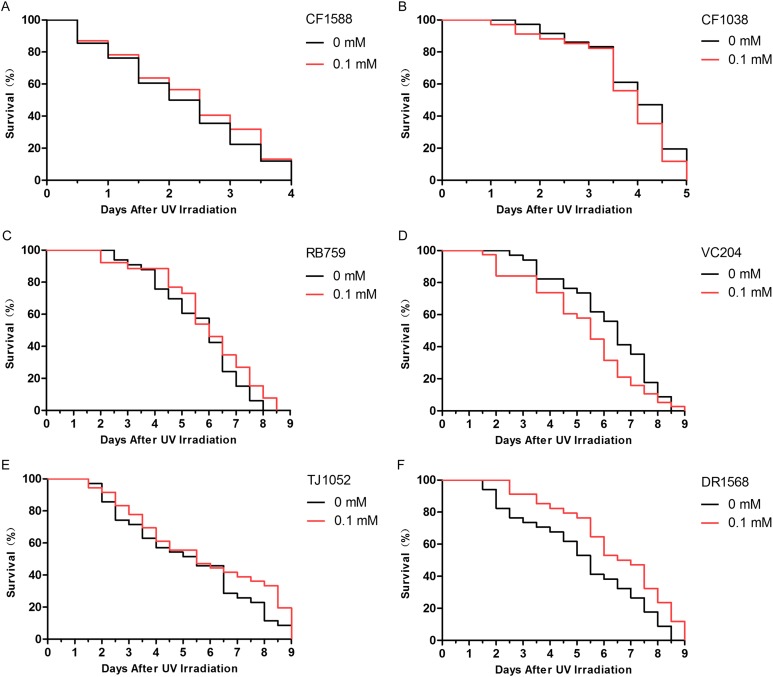
Didymin acted through the insulin/IGF-1-like signaling pathway in C. elegans.Six kinds of adult mutant nematodes were treated with 0.1 mM didymin for 48 h, followed by UV irradiation. The didymin-treated mutants (A) daf-2 and daf-16 (n > 100, p > 0.05), (B) daf-16 (mu86) (n > 100, p > 0.05), (C) akt-1 (ok525) (n > 100, p > 0.05), (D) akt-2 (ok393) (n > 100, p > 0.05), and (E) age-1 (hx546) (n > 100, p > 0.05) reversed their resistance to UV irradiation. However, the didymin-treated mutant (F) daf-2 (e1371) (n > 100, p < 0.001) failed to reverse its resistance to UV irradiation, indicating that didymin might act on DAF-2 to increase the lifespan of C. elegans nematodes exposed to UV irradiation.